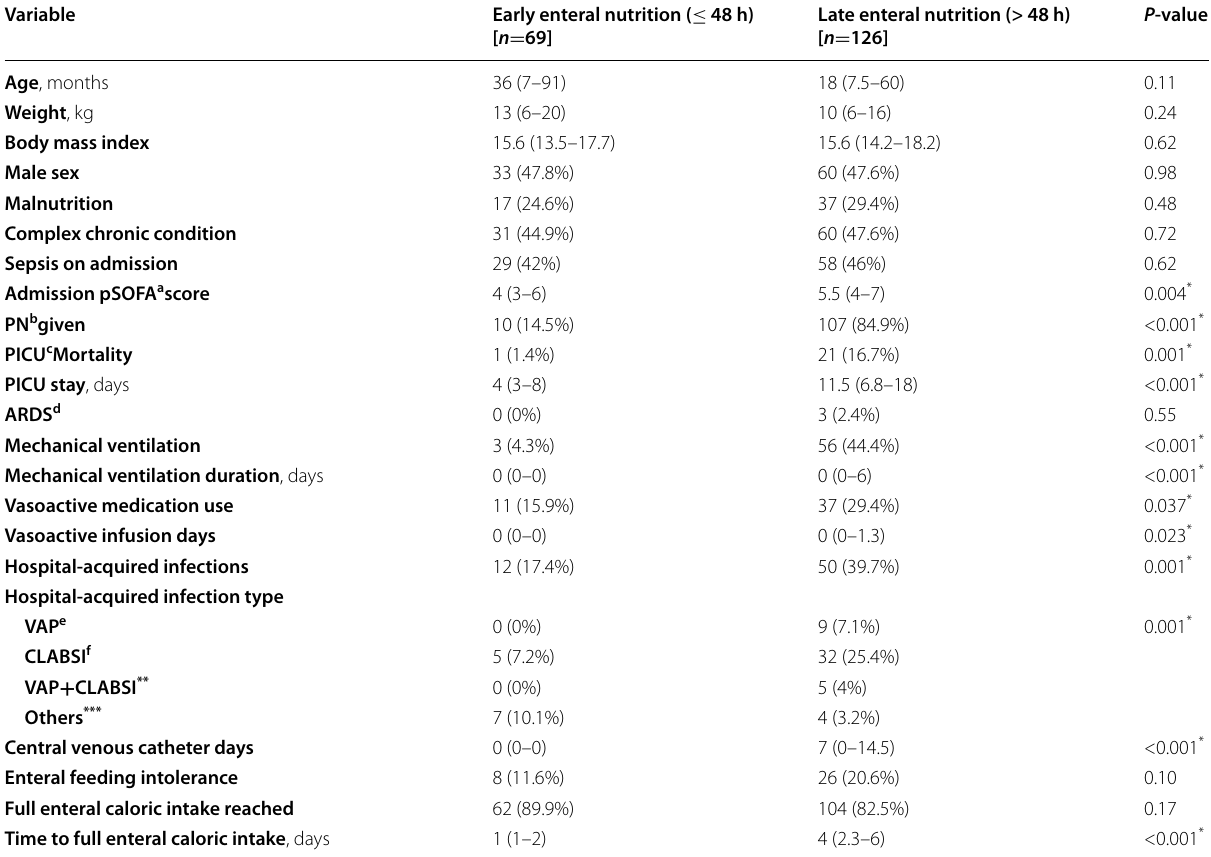
Table 2 Early versus late enteral